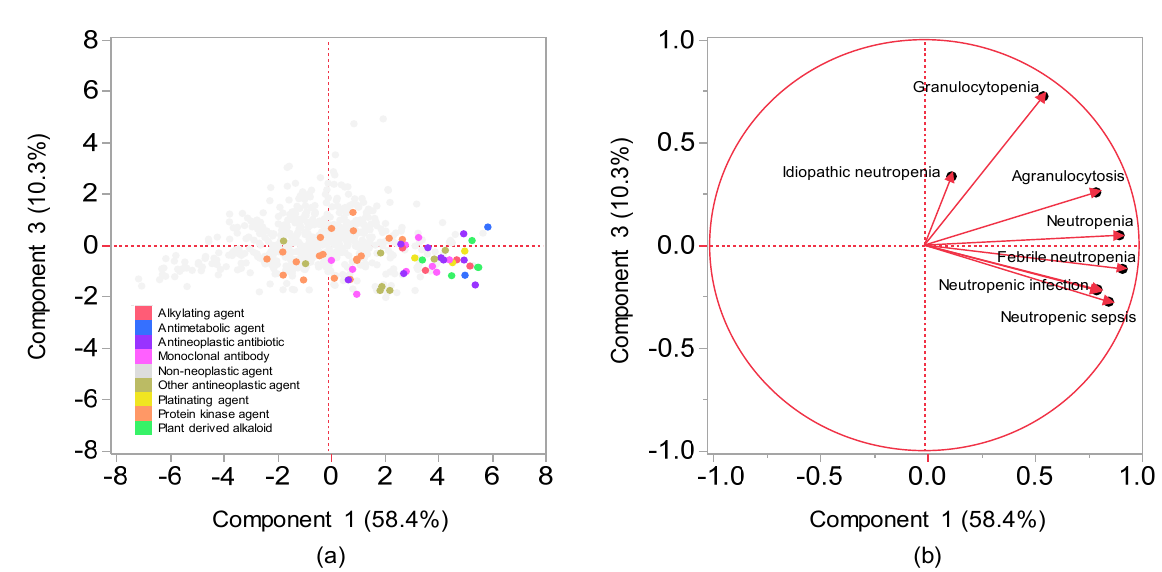
Figure 5. Relationships between CIN and drugs using principal component analysis. ( a ) Score plot; ( b ) loading vectors. ( a ) The score plot shows the relationships between the drugs and principal components. Each plot indicates a drug. Plot colors indicate Anatomical Therapeutic Chemistry classification. ( b ) Loading vectors represent the relationship between side effects and principal components. Each loading vector indicates a side effect.